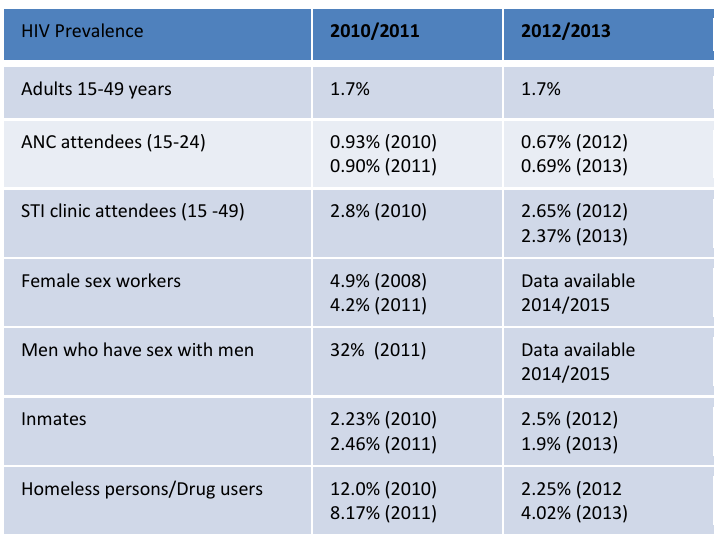
Table 2: Prevalence by key risk